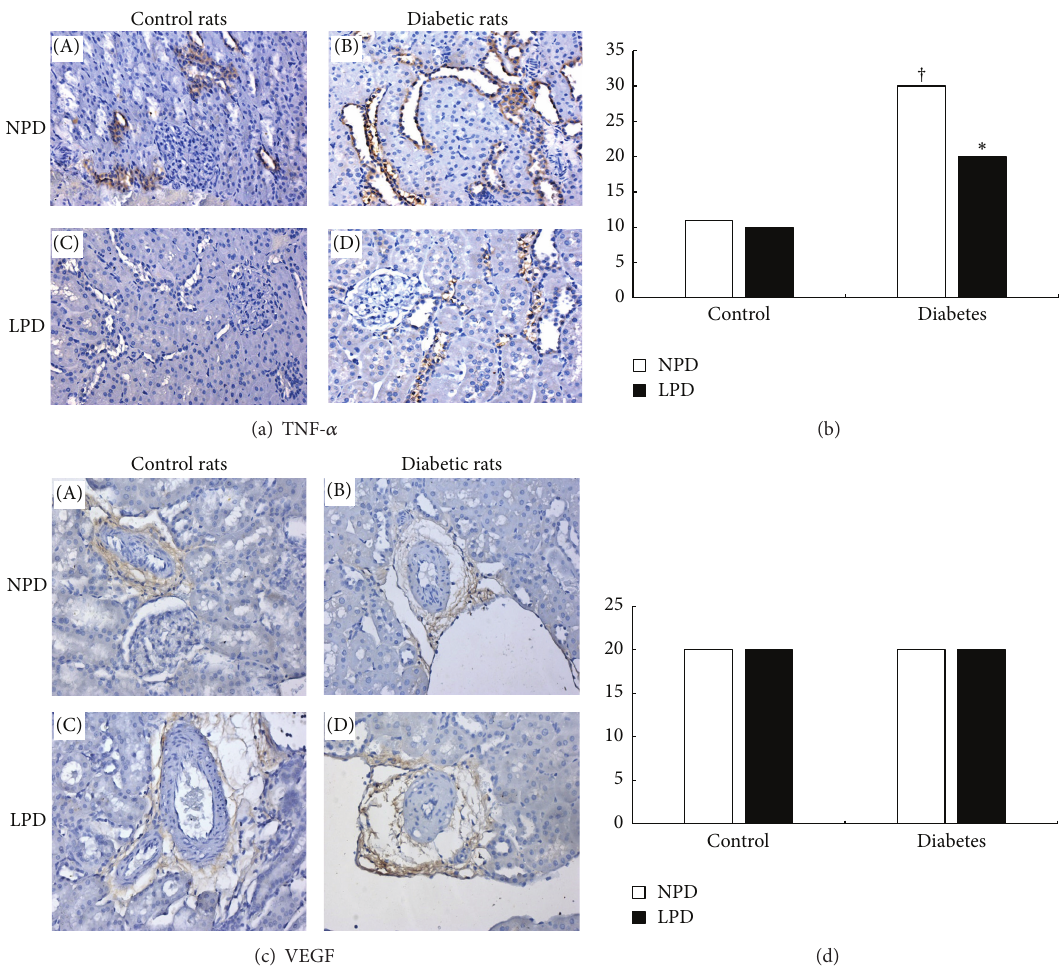
Figure 6: Effects of LPD on tumor necrosis factor 𝛼 (TNF- 𝛼 ) and vascular endothelial growth factor (VEGF) expressions in glomeruli and tubulointerstitium. (a) Immunohistochemical staining of TNF- 𝛼 . TNF- 𝛼 mainly expressed in the tubulointerstitial area either in control or diabetic rats. As compared with control rats ((A), (C)), diabetic rats ((B), (D)) expressed more abundant TNF- 𝛼 (the brown color) in this area. LPDonlysignificantlyreducedTNF- 𝛼 expressionindiabeticrats(d)butnotincontrolrats(C).(b)QuantitativescoresofTNF- 𝛼 expressionin tubulointerstitium. (c) Immunohistobiochemical staining of VEGF. VEGF occasionally expressed around some arterioles. Diabetic rats ((B), (D)) expressed comparable VEGF as control rats ((A), (C)). LPD exerted no effects on VEGF expressions either in control (C) or diabetic rats (D). (d) Quantitative scores of TNF- 𝛼 expression around arterioles. In (B) and (D), NPD is shown as ( ◻ ) and LPD is shown as ( ◼ ). † 𝑃 < 0.05 compared with C-NPD group. ∗ 𝑃 < 0.05 is compared with D-NPD